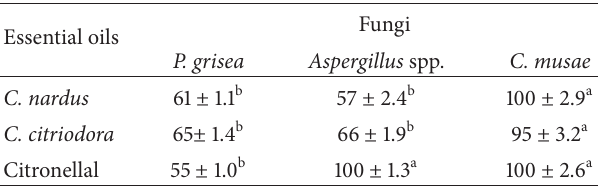
a Values are the mean of three replicates ± SE. Where the letters are the same, there is no significant difference between the fungal species at